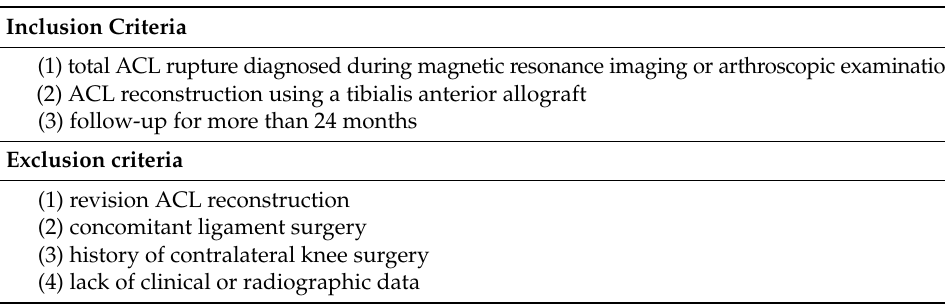
Table 1. Inclusion and exclusion criteria of the study.